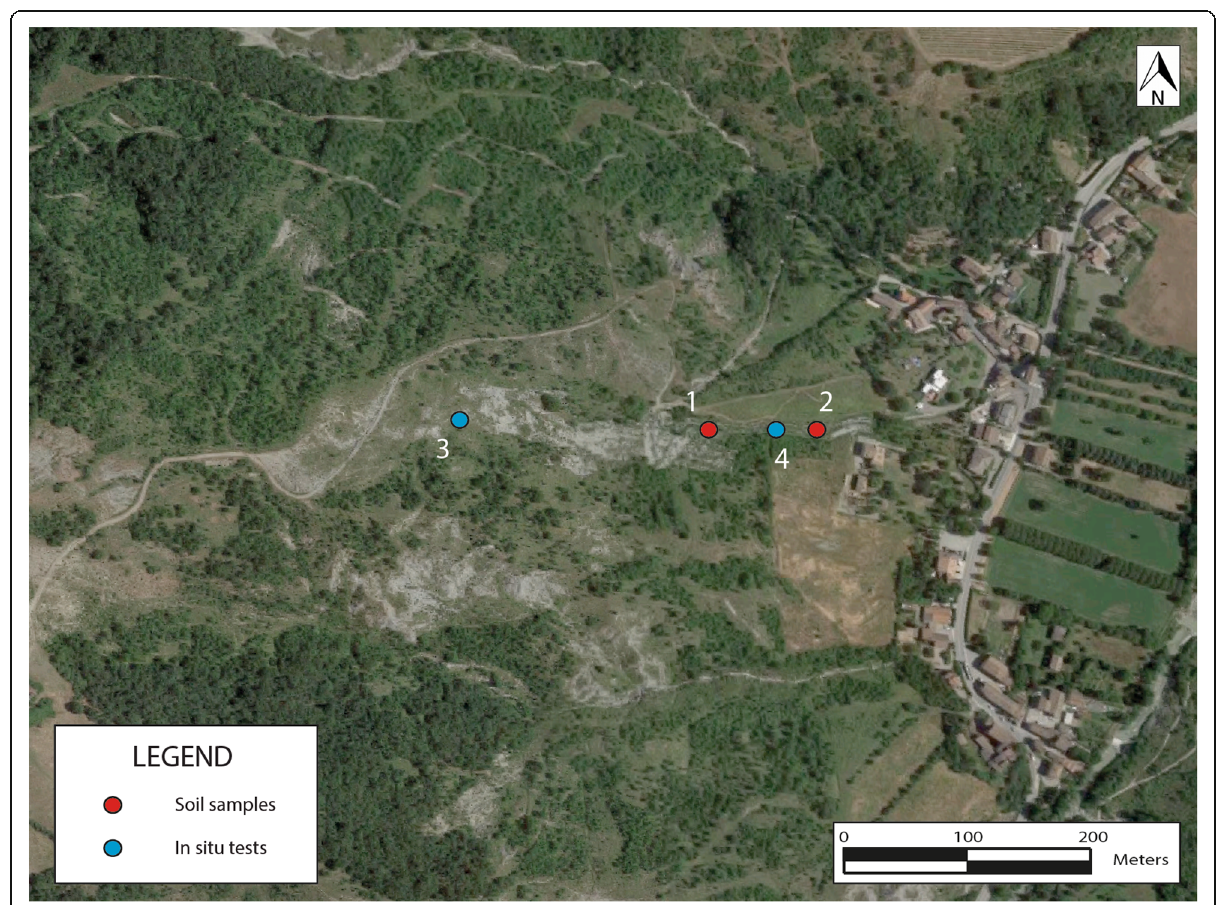
Fig. 5 Location of the soil samples (in red) and the geotechnical field investigation (in cyan); point 3: permeability measurement; point 4: permeability measurement and